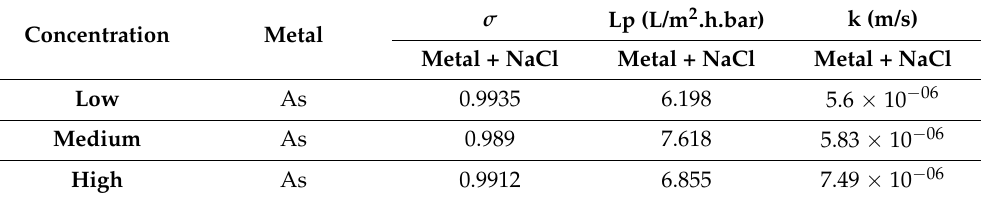
Table 5. Calculation of non-linear parameters of the model by concentrations for the As.